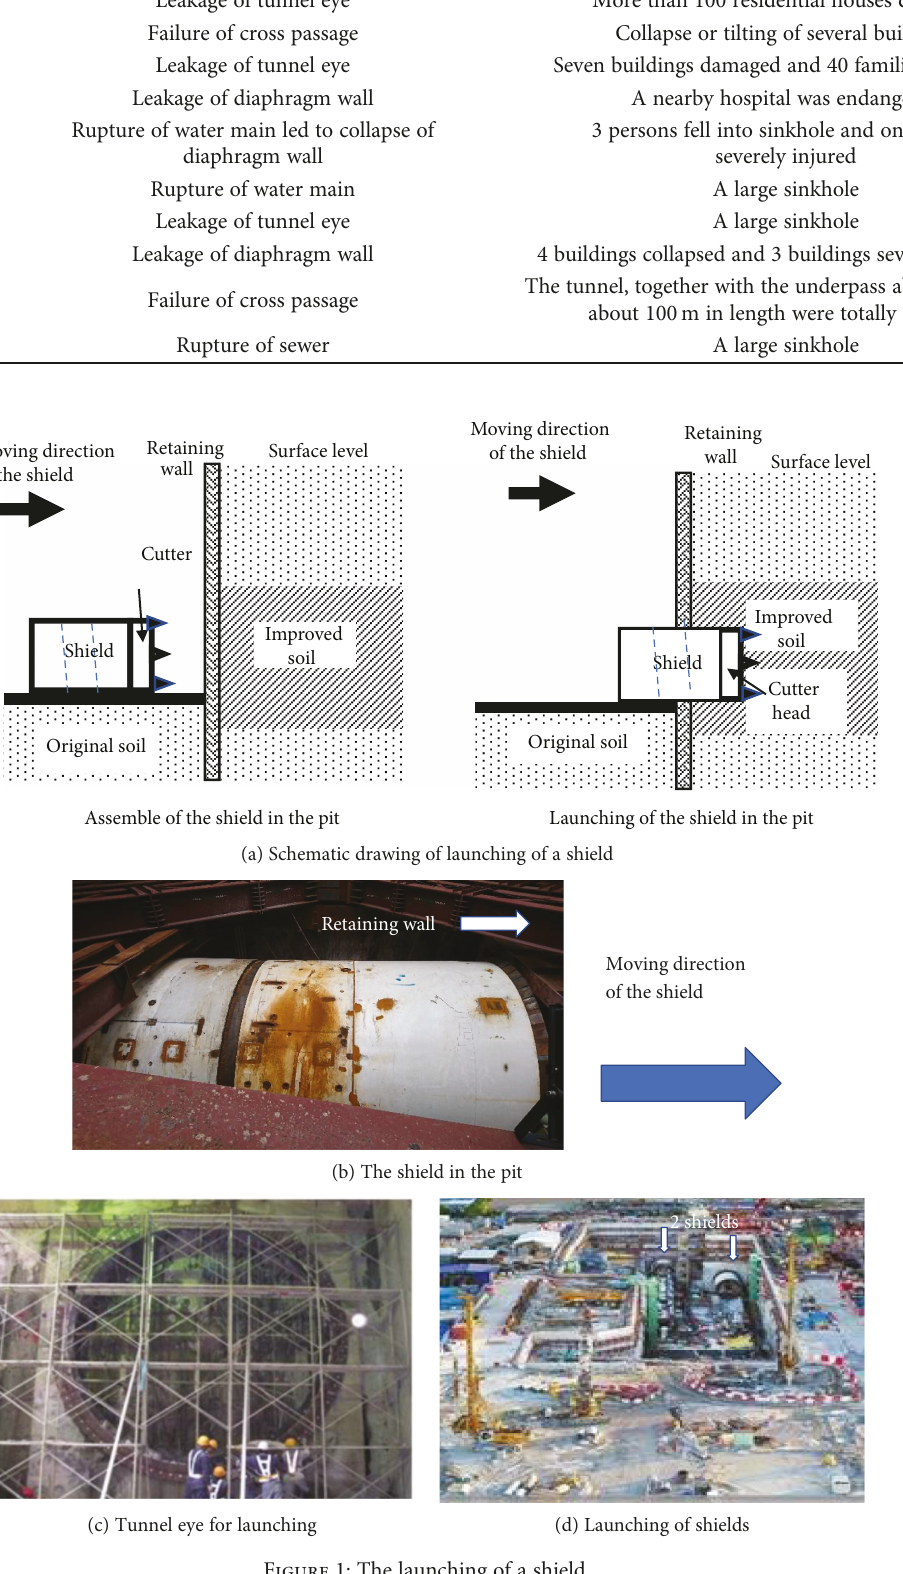
Figure 1: The launching of a